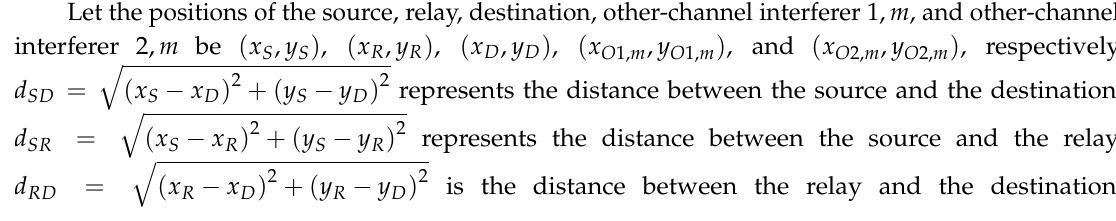
Figure 7. Interference from other sub-channels.